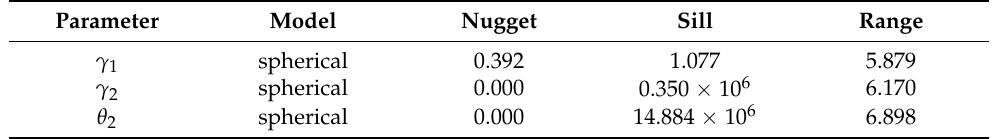
Table 4. Parameters of theoretical semivariogram models for the north